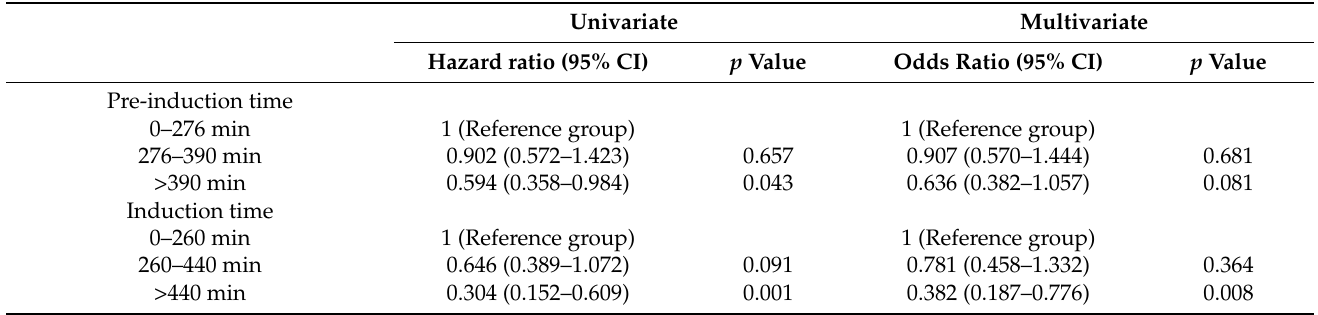
Table 5. Univariant and multivariant Cox model results for mortality at 28 days. Univariate